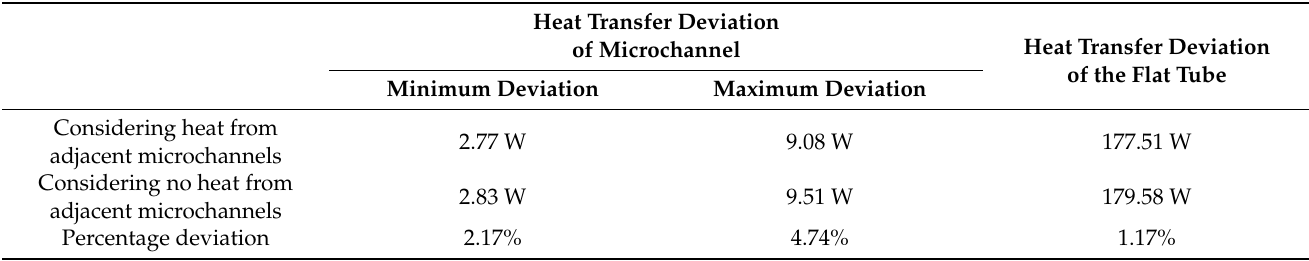
Figure 21. Influence of the heat transfer from adjacent microchannels. Table 4. Deviation considering the heat from adjacent microchannels.